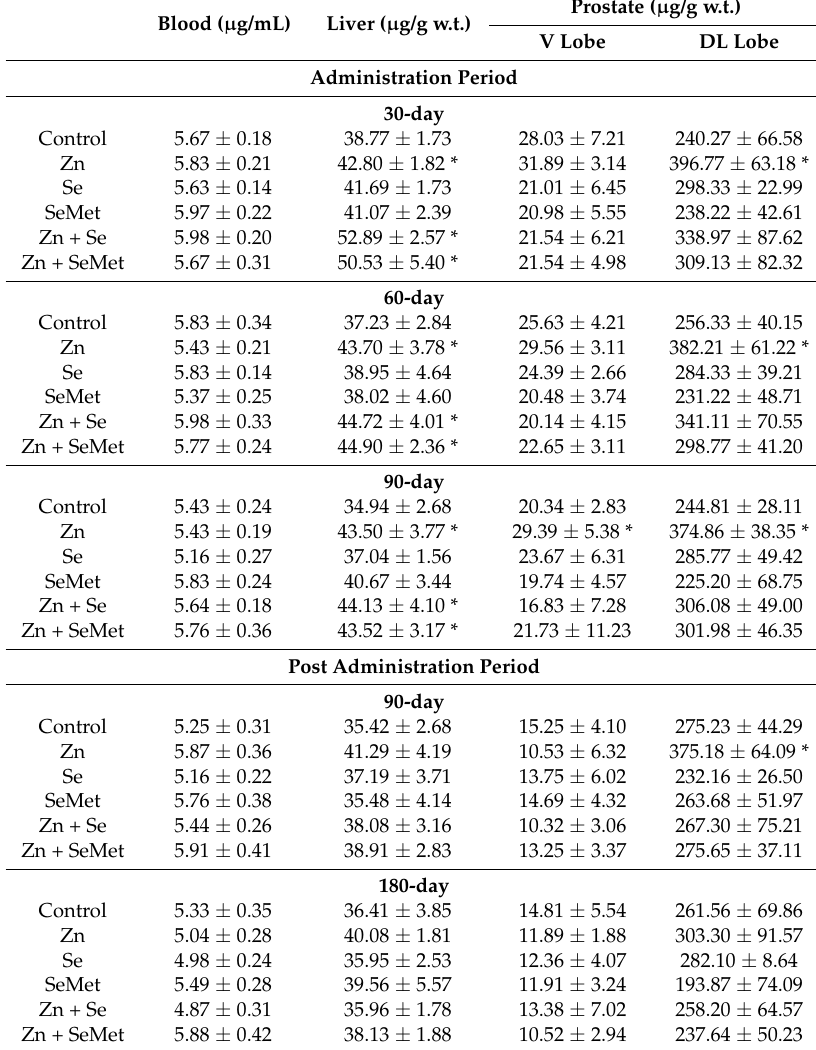
Table 1. Zinc level in the blood, liver and prostate of rats following zinc gluconate (Zn), sodium selenite (Se) and selenomethionine (SeMet) administration given jointly or separately for 30, 60 and 90 days and then after 90 and 180 days post